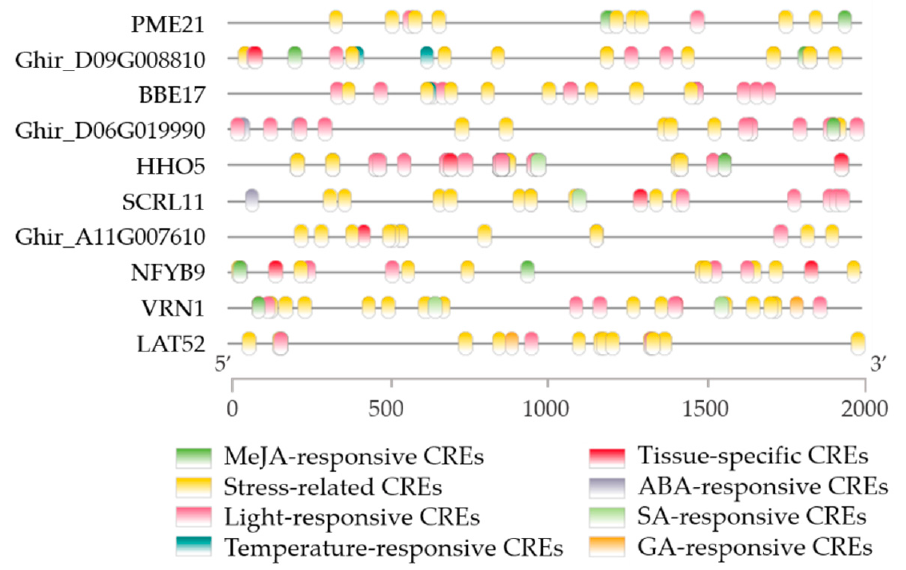
Figure 9. The distribution of CREs in the 2-kb promoters of 10 shared genes in PSGs and DEGs. The distribution of CREs was drawn by software TBtools, and 8 CREs were shown (not including the TATA box and CAAT